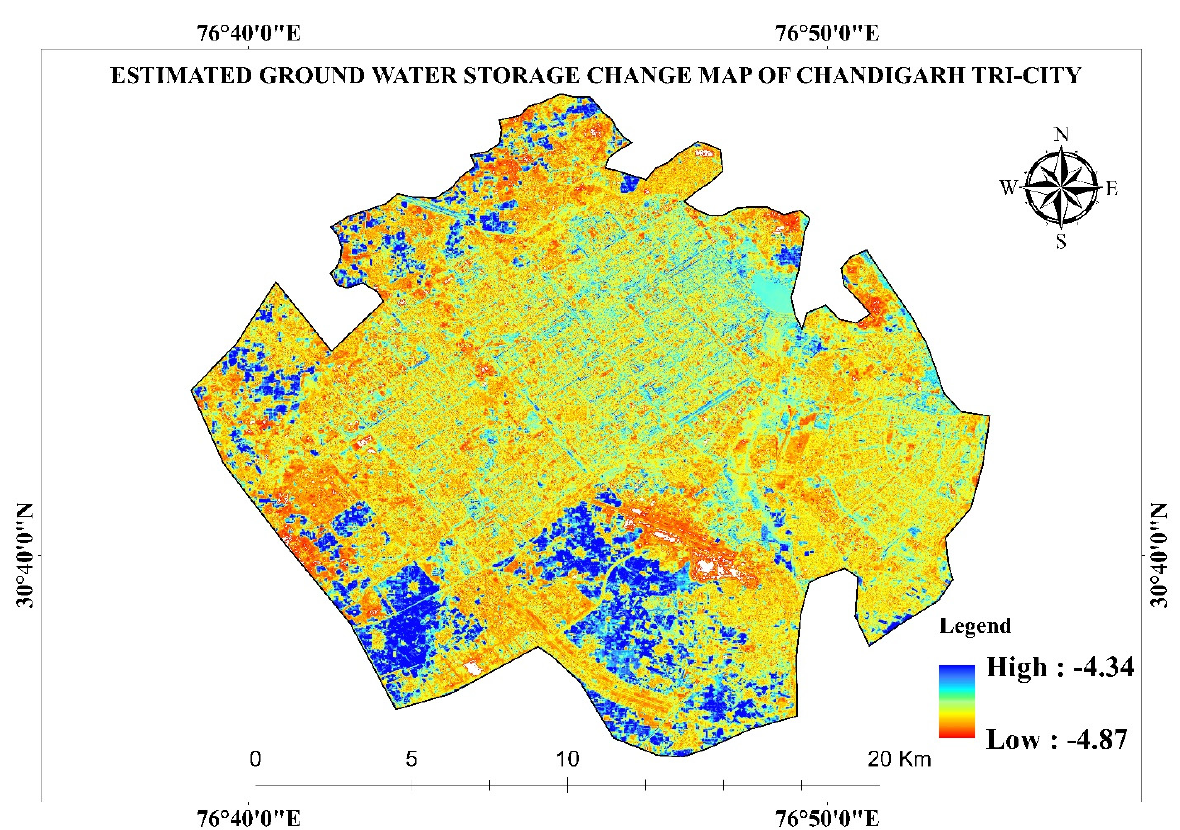
Figure 11. Estimated gravimetric anomaly map for Chandigarh tri-city (in mGAL).